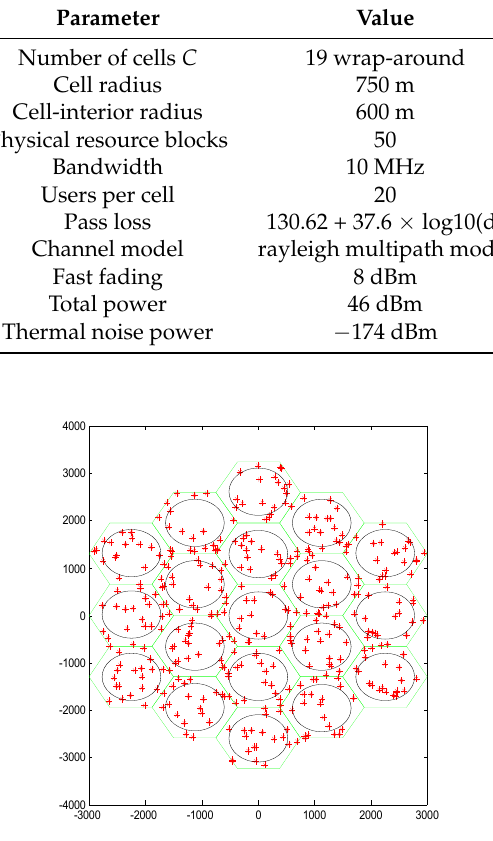
Figure 3. User distribution in 19 cells.